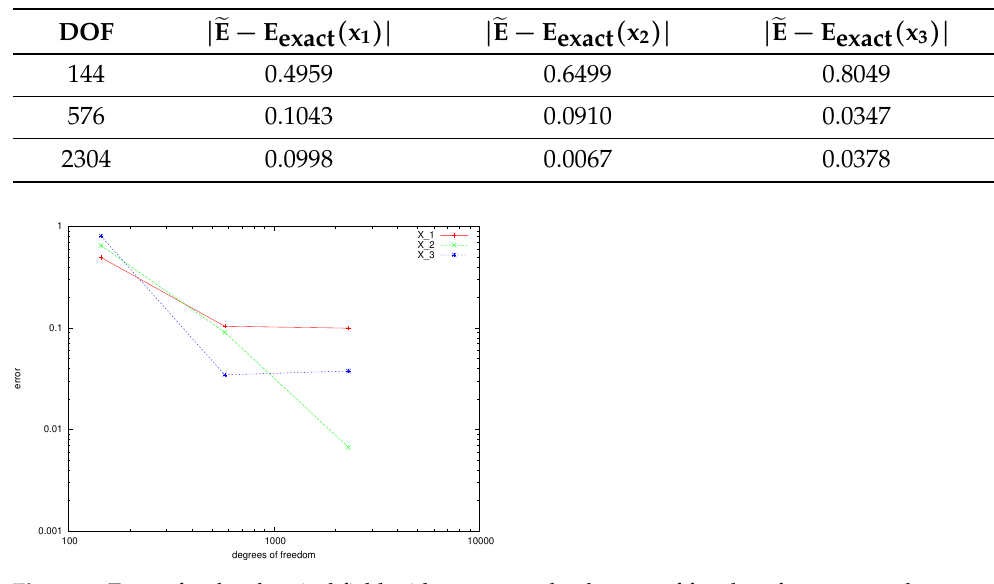
Figure 3. Errors for the electrical field with respect to the degrees of freedom for x 1 , x 2 , and x 3